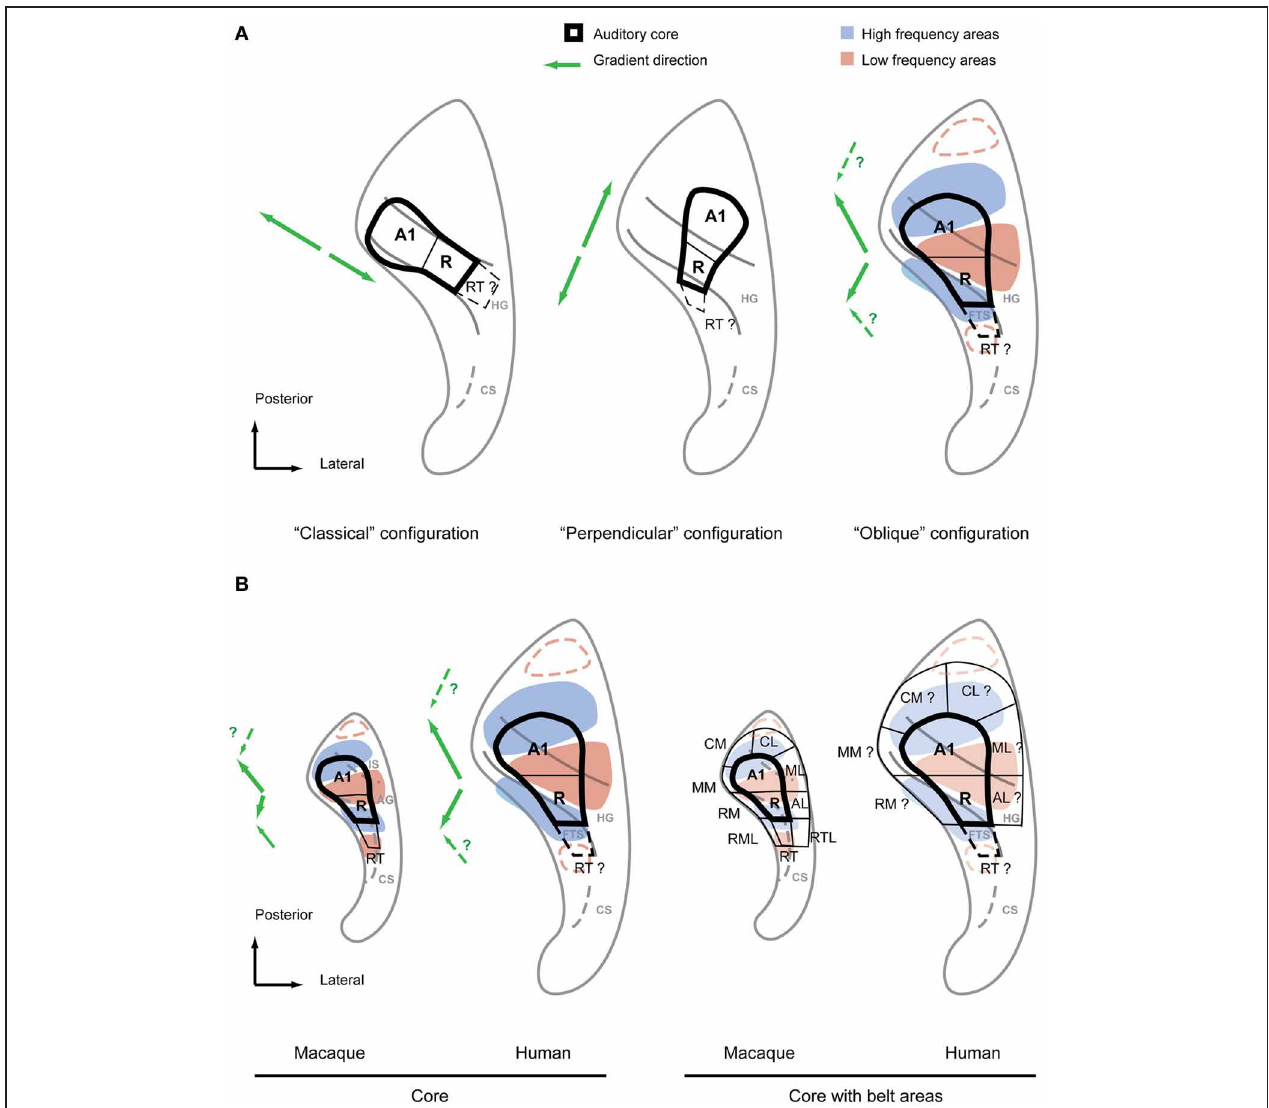
FIGURE 3 | Debated configurations of auditory cortical organization in humans and non-human primate configuration for comparison. (A) The two main configurations of auditory core fields under debate (left, middle) in comparison with the “oblique” configuration proposed by the authors (right). The main frequency response areas based on the summary of recent evidence (Formisano et al., 2003; Humphries et al., 2010; Woods et al., 2010; Da Costa et al., 2011; Striem-Amit et al., 2011; Langers and van Dijk, 2012) are superimposed over this configuration. The suggested directions of the main gradient axes are indicated with